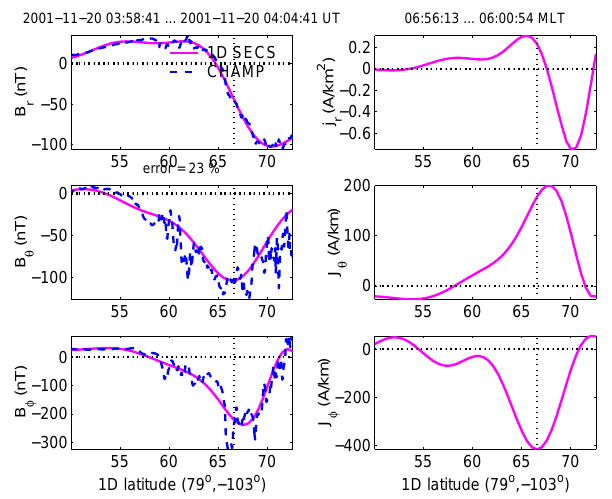
Fig. 2. Magnetic field measured by CHAMP and the ionospheric current density computed using the 1-D SECS method as a func- tion of 1-D latitude on 20 Nov 2001 between 03:59–04:04UT. B r , B θ , and J φ are determined from B r and B φ , j r , and J θ from B φ . The north pole of the 1-D coordinate system is located at 79 ◦ GEO lat and -103 ◦ lon. In these coordinates, J cf (θ) = J θ (θ) ˆ θ and J df (θ) = J φ (θ) ˆ φ